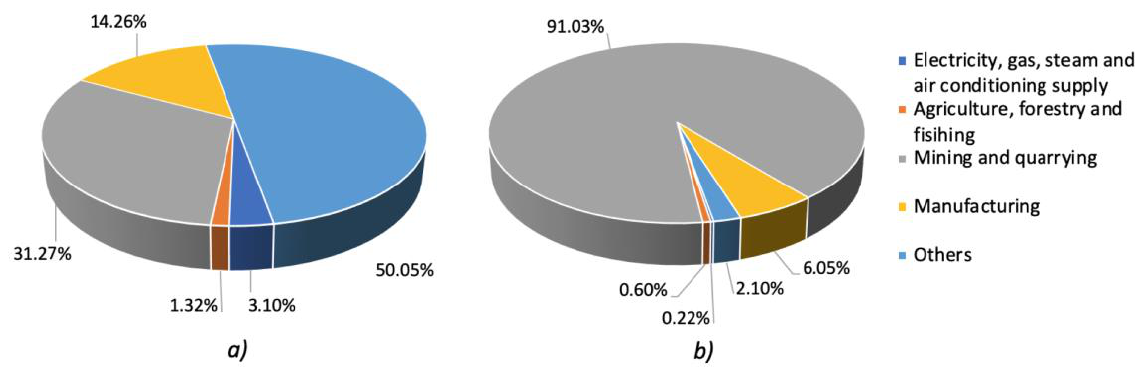
Figure 1. Structure of production waste generation (here and hereafter presented data not including nuclear waste): ( a ) in EU 2020, % ( b ) in Russia 2021, % (made by authors using data from [9,10]). The volume of production waste generation in the analyzed sector in the EU is higher than in Russia, which might be due to the specifics of waste generation accounting and environmental reporting at Russian and European energy enterprises. For instance, waste sent by Russian enterprises for disposal, decontamination, or recycling within the frame- work of reporting is reflected only in those organizations where these wastes are sent. enterprise.